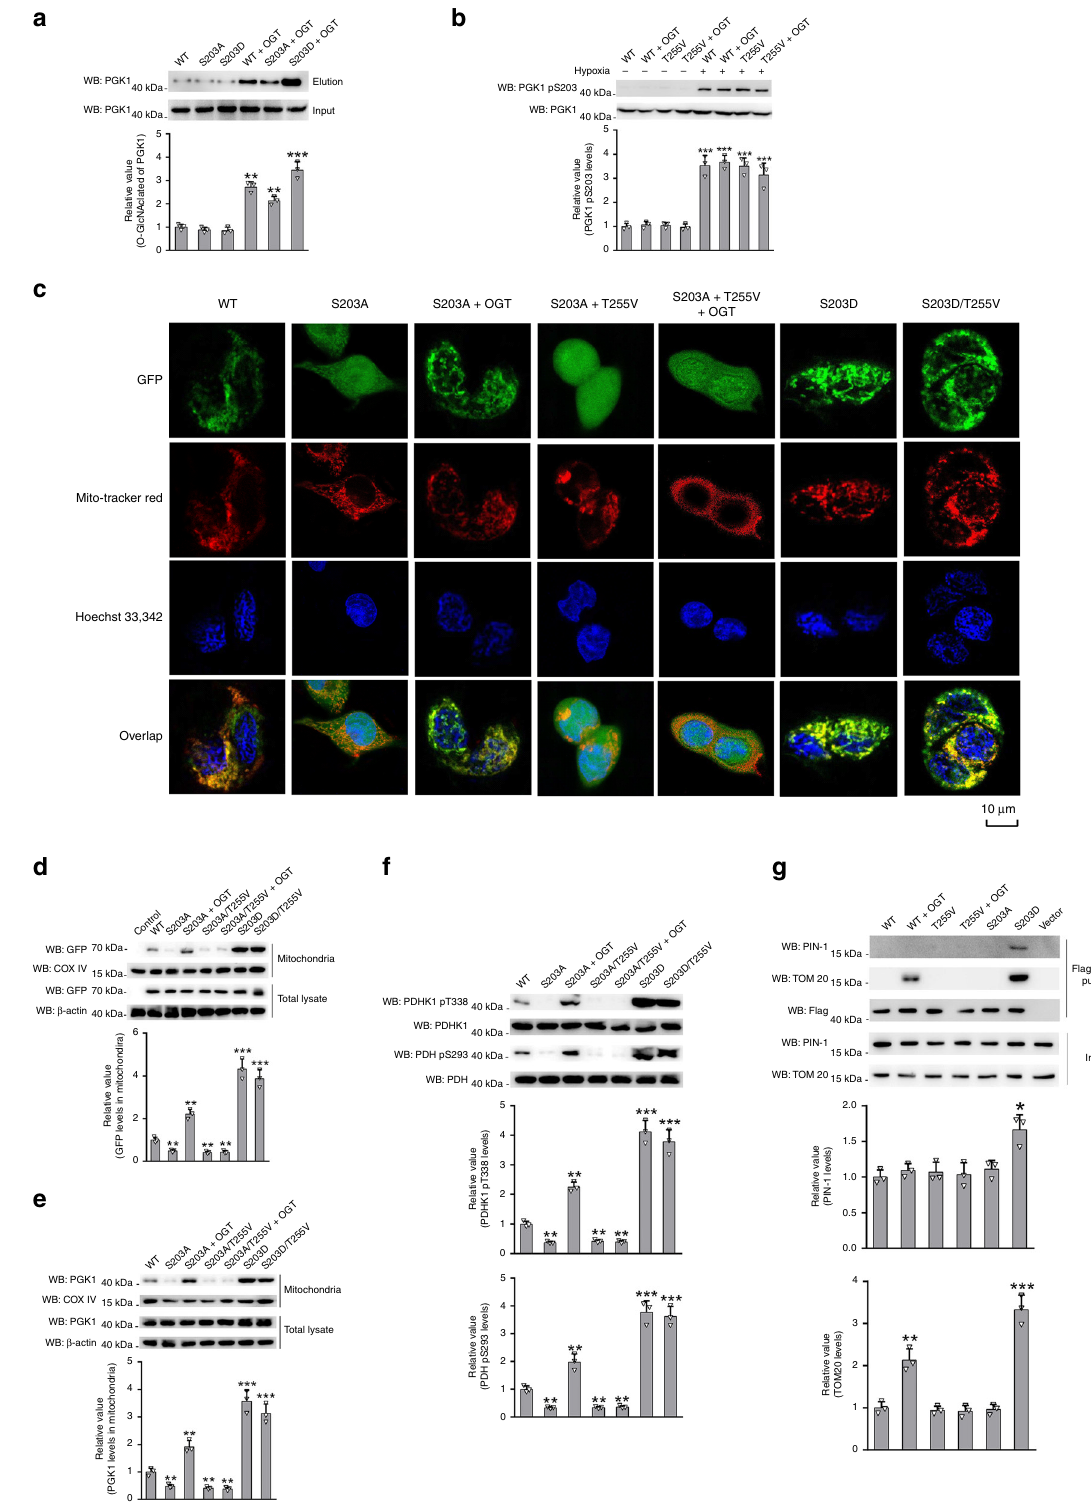
T255 O-GlcNAcylation of PGK1 regulates glucose metabolism in cells . According to the Warburg effect, proliferating cancer cells preferentially use glycolysis over mitochondrial oxidative phosphorylation for glucose-dependent ATP production. They consume a large amount of glucose, maintain a high rate of glycolysis and convert the majority of glucose into lactic acid. Our results demonstrated that O-GlcNAcylation not only increased